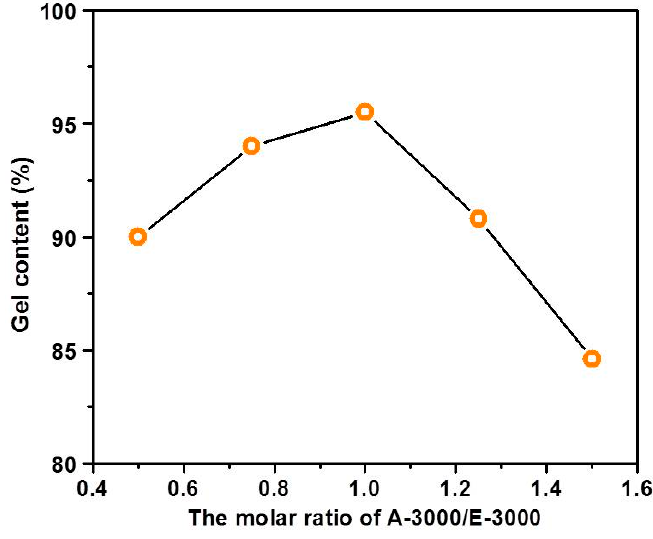
Figure 3. The effect of molar ratio of the two selected polymers on gel content.